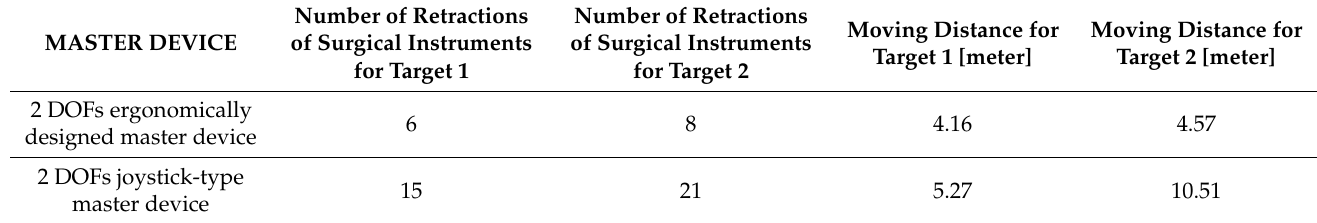
Table 2. Moving distance and the number of retractions of surgical instruments (mean) for hepatic artery and splenic artery.